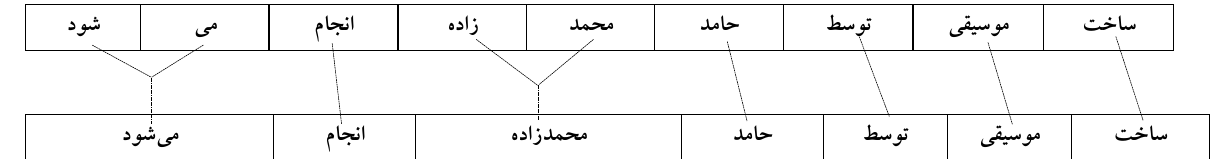
Figure1. Word alignment in Persian